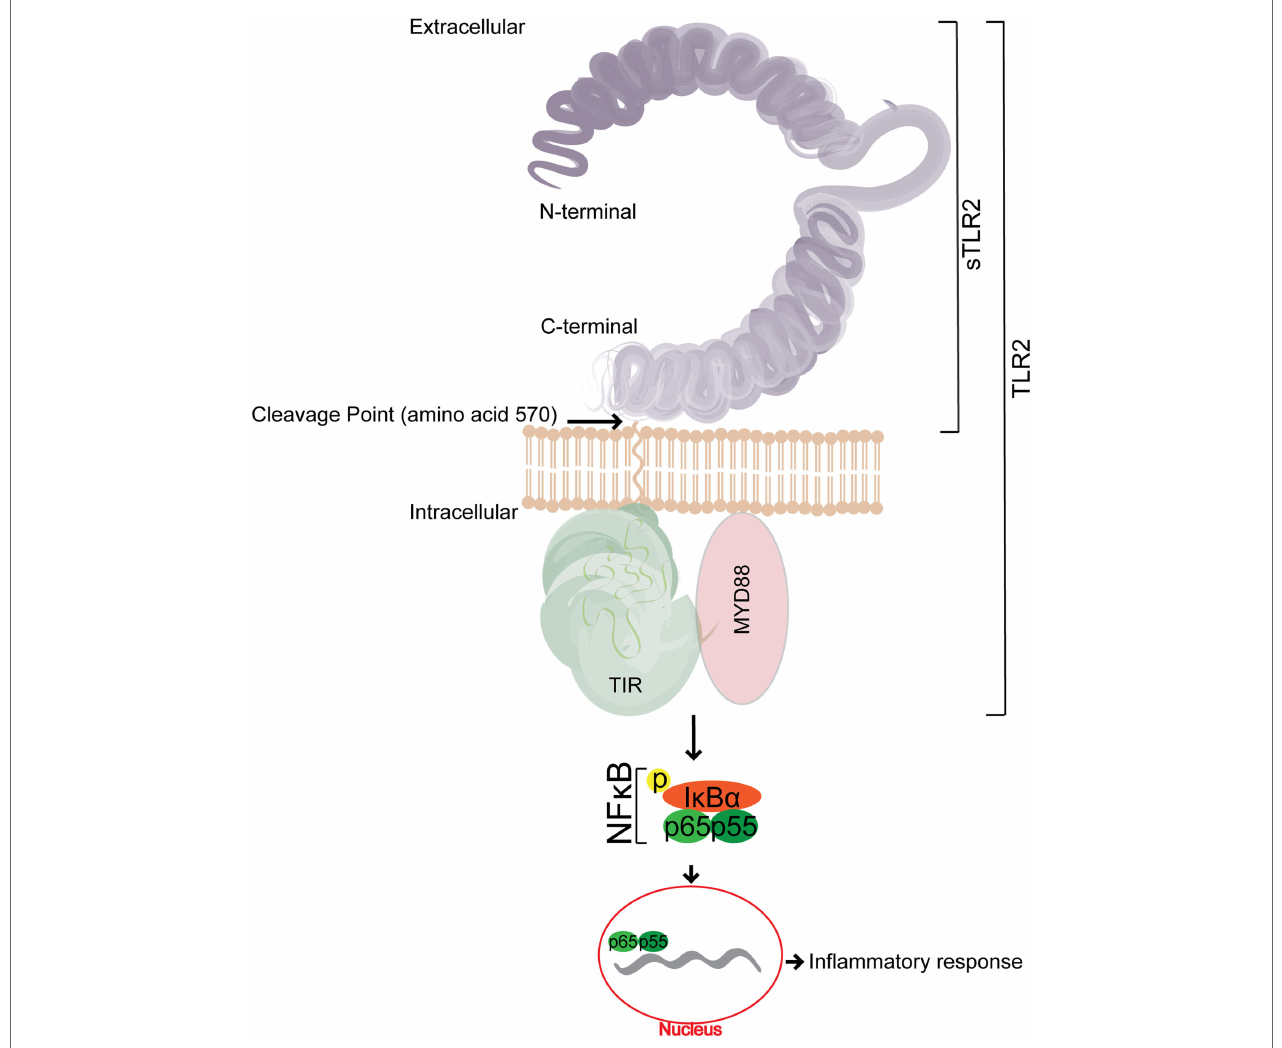
FiGURe 1 | A representative schematic of the structure of soluble TLR2 (sTLR2) . sTLR2 comprises the extracellular portion of TLR2 and does not contain the transmembrane nor the TIR domains required for TLR2 signaling. The size of sTLR2 varies in different mucosal fluids, and is composed of cleaved portions of the N and C